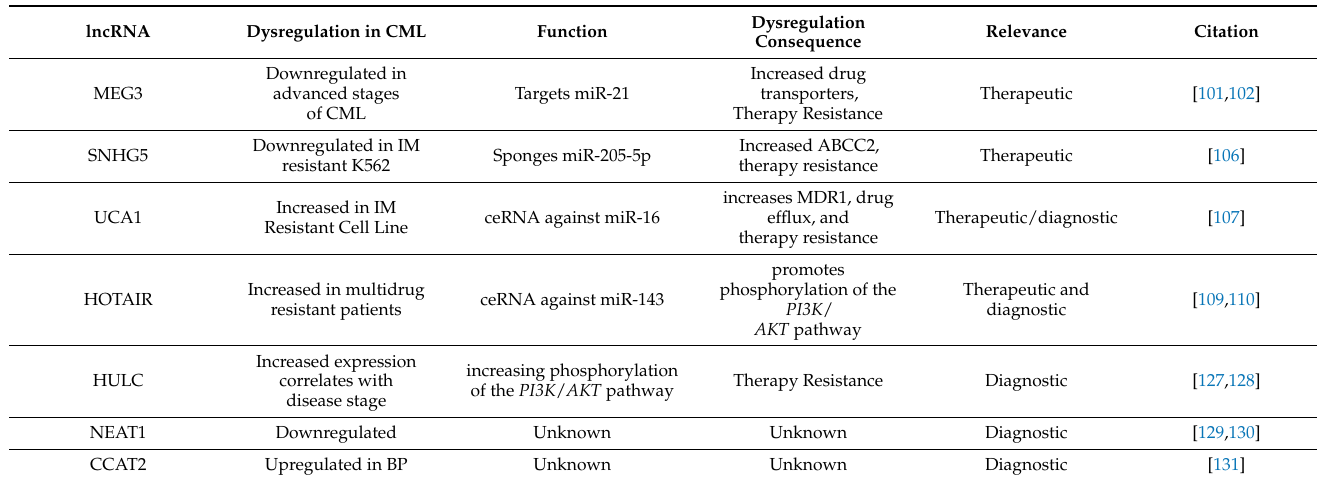
Table 3. Summary of discussed lncRNAs dysregulated in CML.